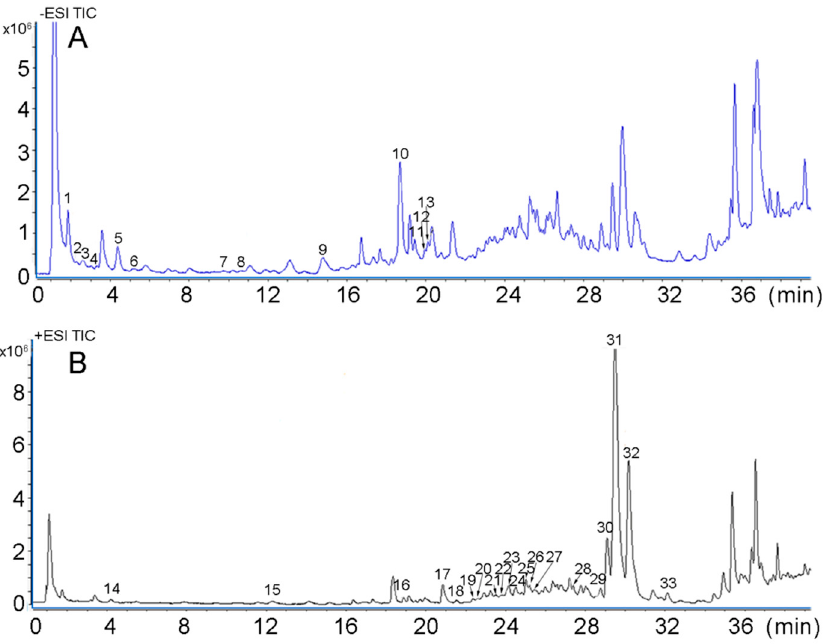
Figure 2. UHPLC–Q–TOF–MS/MS chromatograms of Notopterygii rhizoma and radix extract. ( A ) Total ion current in a negative ion mode; ( B ) Total ion current in a positive ion mode.